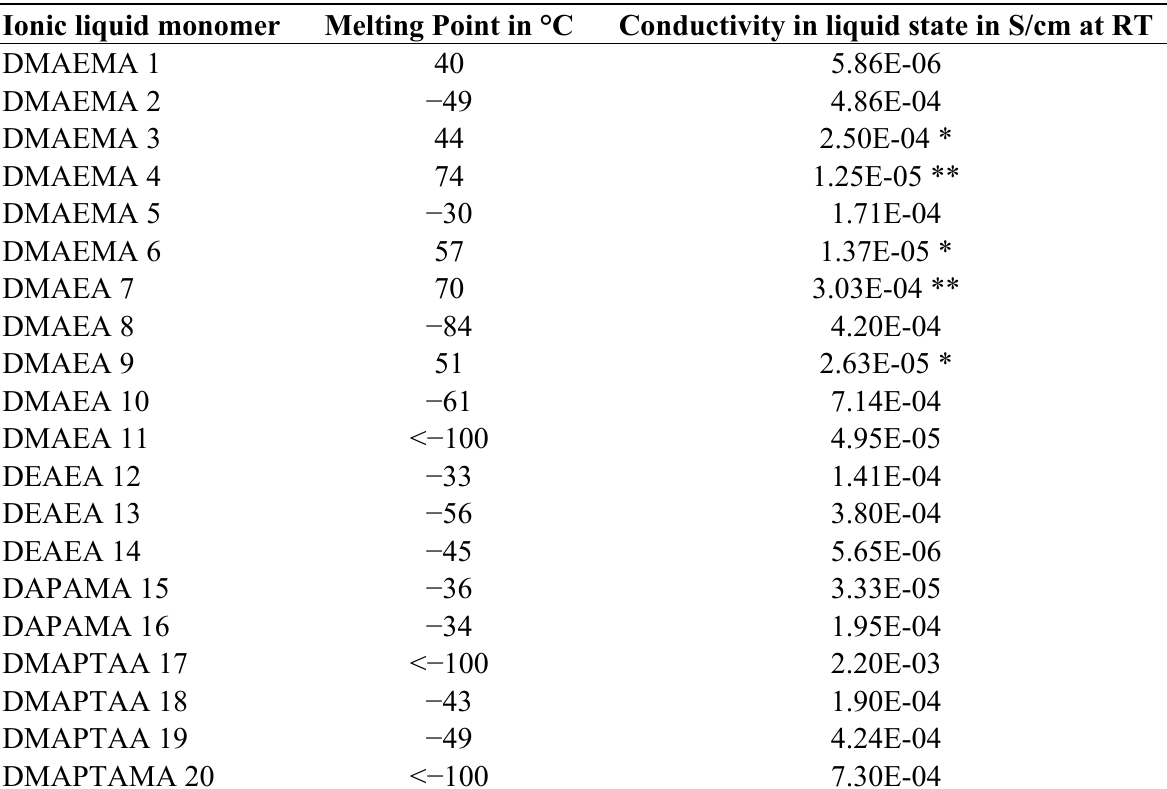
Table 1. Melting points and conductivity.